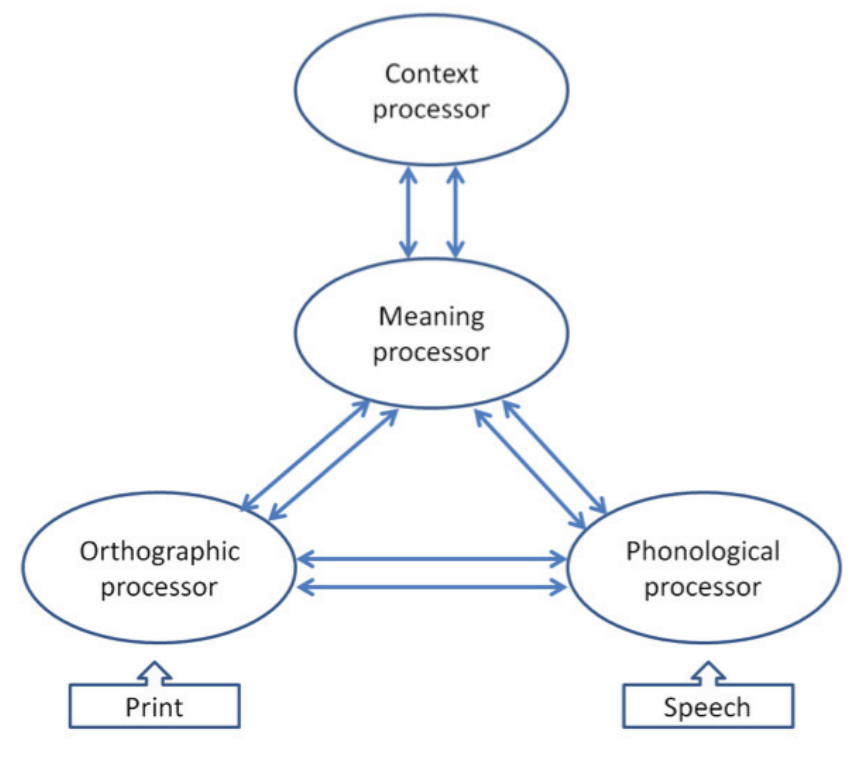
Figure 1: Parallel distributed processing (pdp) model from Adams (1990: 158)